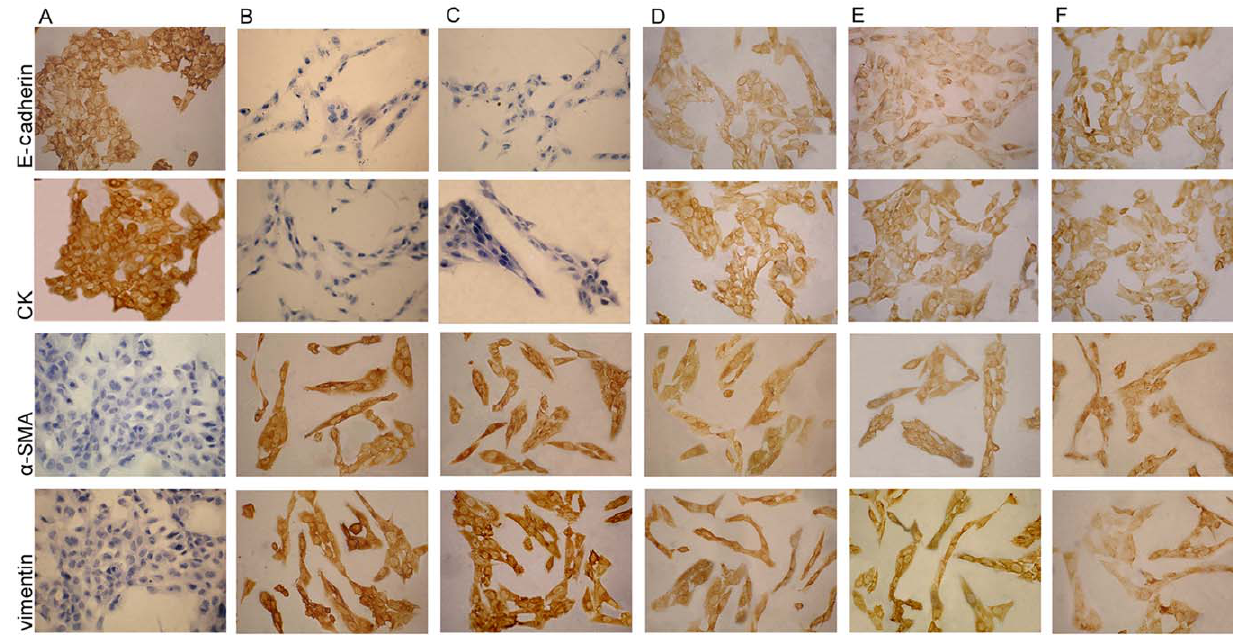
Figure 4. Expression of E-cadherin, CK, a -SMA, vimentin in HK-2 cells by immunochemistry. (A–C)The HK-2 cells under 30 mM glucose(B) or 30 mM glucose + cont siRNA(C) showed a loss of CK and E-cadherin and an increase of a -SMA and vimentin expression compared to that of the cells under 5.5 mM glucose condition(A).(D–F)These changes were prevented by exposed to 30 mM glucose + p38siRNA for 24 h(D) or 48 h(E) or + AP-1 inhibitor(F).